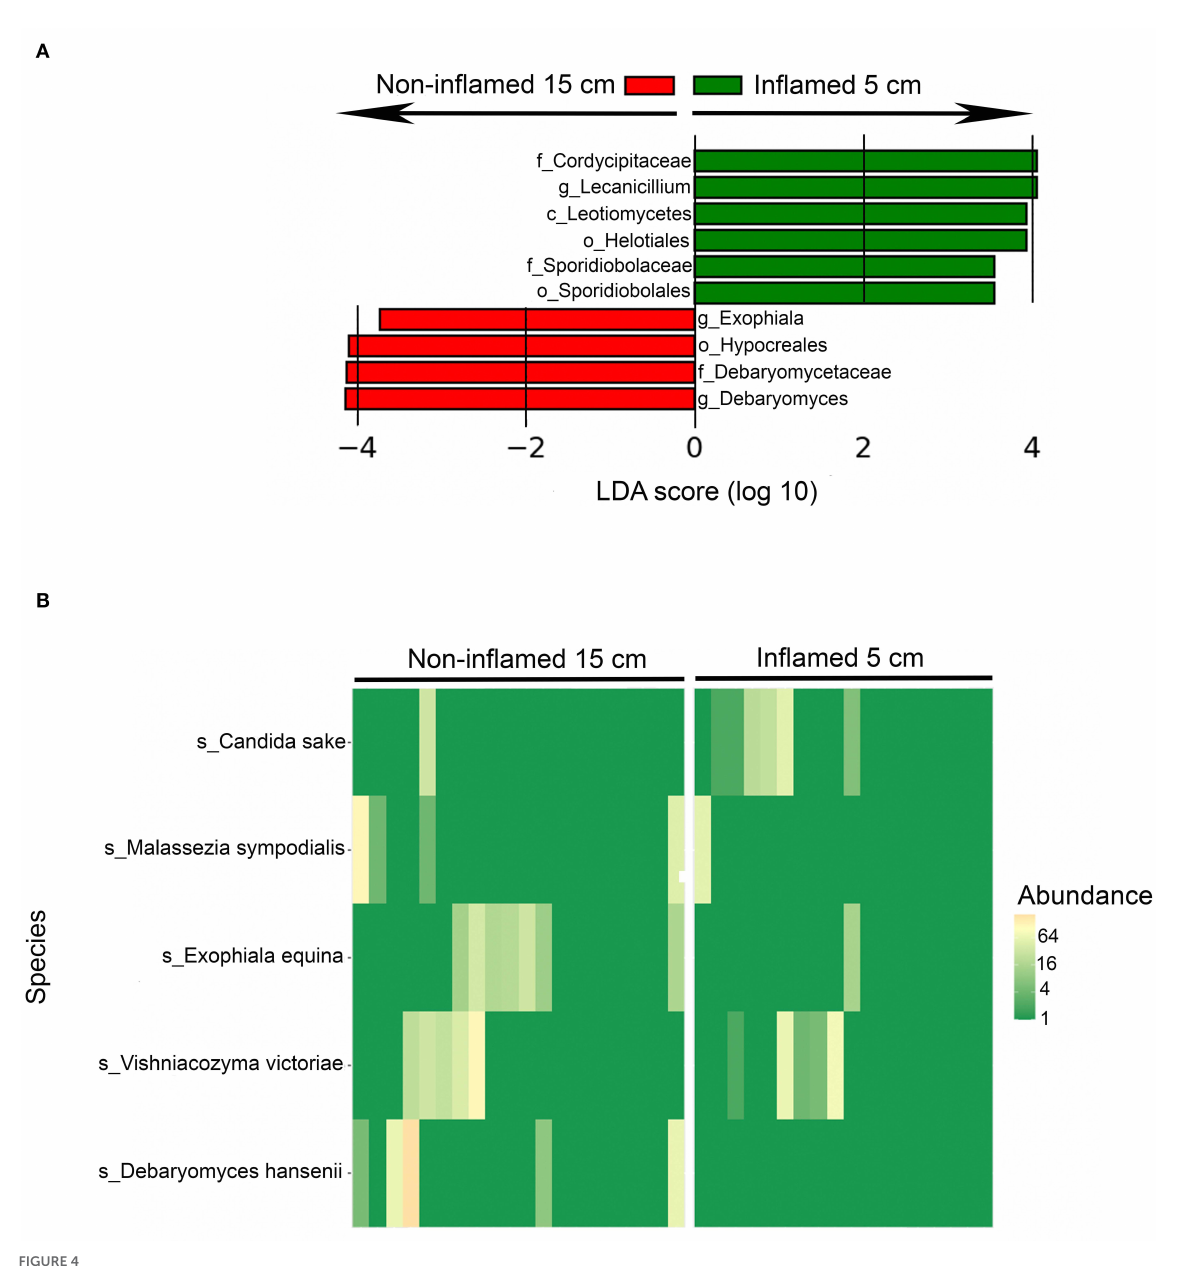
FIGURE4 Differentially abundant fungal taxa between inflamed 5-cm vs. proximal non-inflamed 15-cm ileum of Crohn’s disease (CD) patients ( n = 20) with terminal ileitis and no history of upper CD involvement. Biopsies sampled from 5- and 15cm proximal of the ileocecal valve or ileocolic anastomosis within the same patients. (A) Fungal taxa overrepresented in inflamed 5-cm biopsies (green) and non-inflamed 15-cm biopsies (red) in a histogram with Linear Discriminant Analysis (LDA) score computed using linear discriminant analysis effect size (LEfSe). (B) Heatmap showing the distribution of differentially abundant fungal species in inflamed 5-cm samples (right) and non-inflamed 15-cm samples (left) identified using